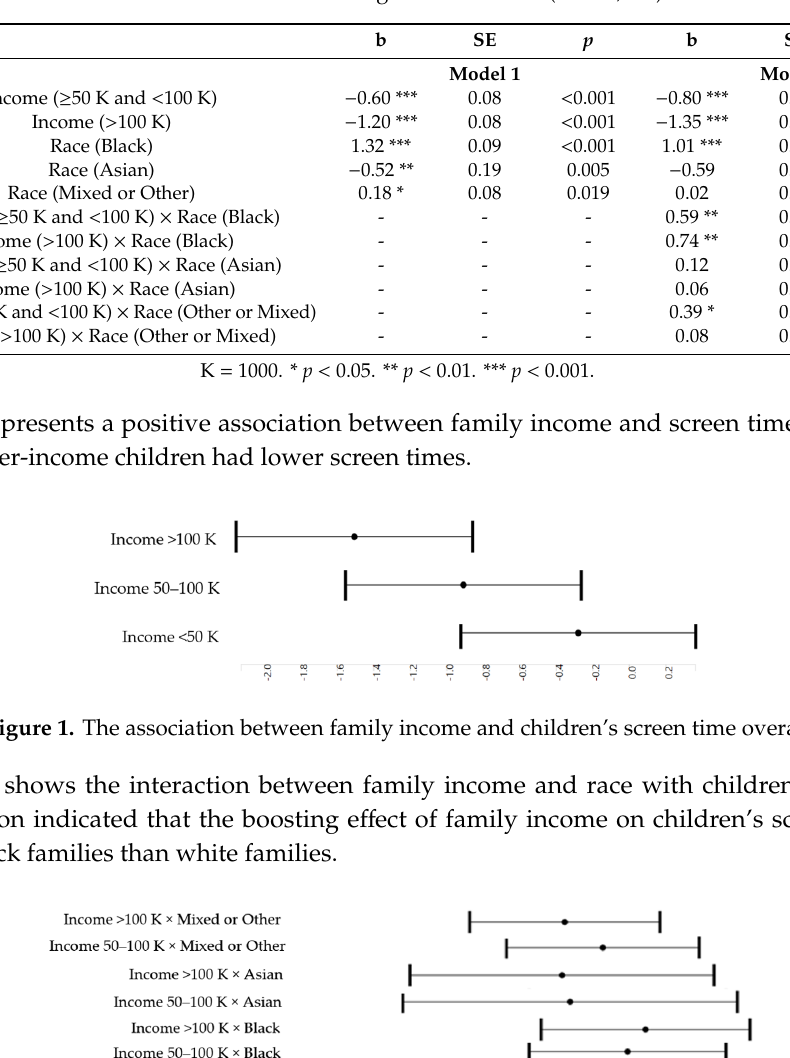
Figure 2. The association between family income and children’s screen time by race.